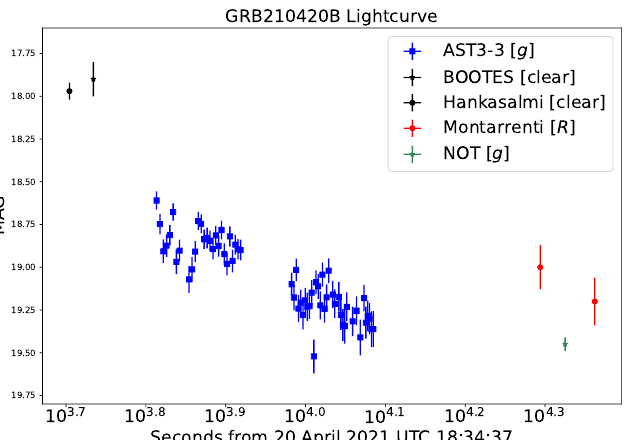
Figure 13. This image shows the light curve of the GRB 210420B. The light curve combines data from AST3-3, BOOTES [98], Hankasalmi [97], Montarrenti [100] and NOT